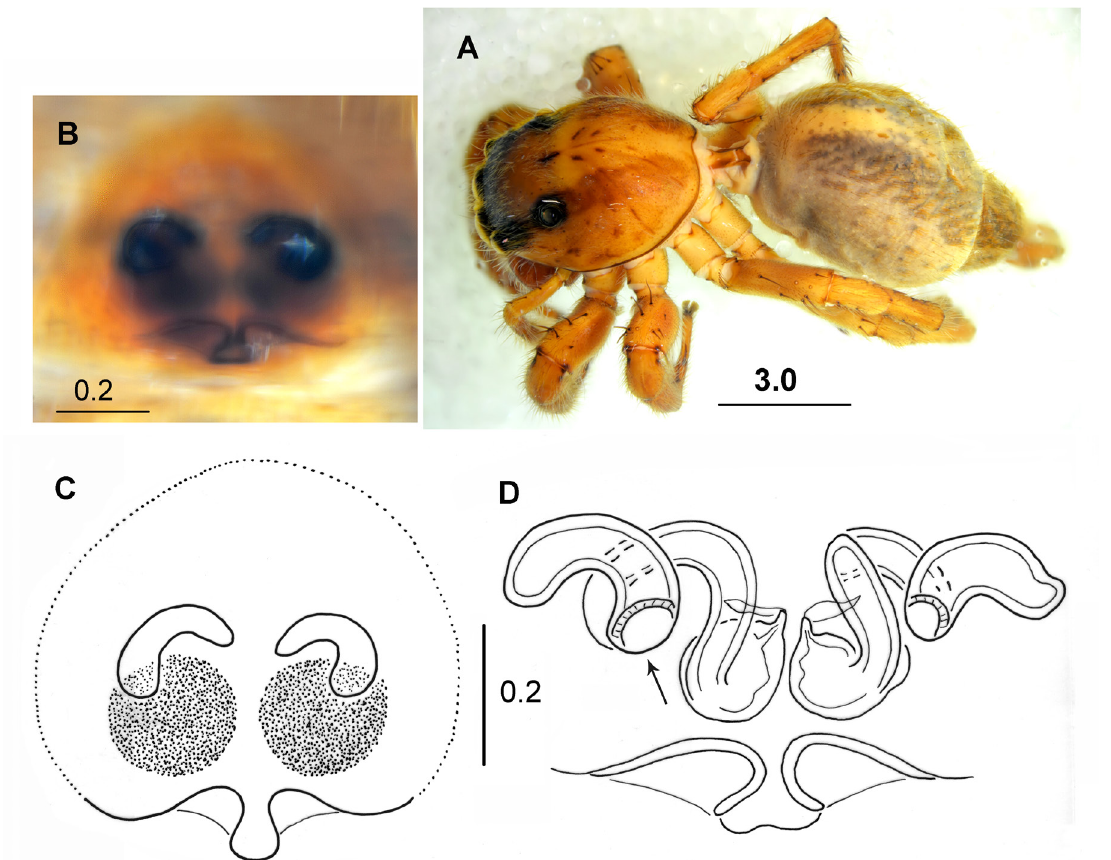
Fig. 23. Hyllus solus sp. nov., holotype, ♀ (MNHN). A . Habitus, dorsolateral view. B–C . Epigyne. D . Internal structure of